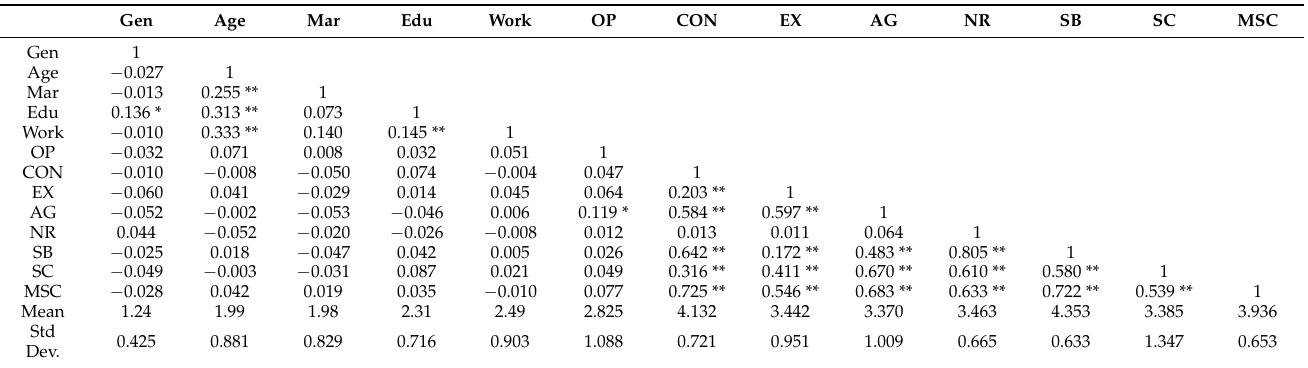
Table 2. Standard Deviations, Means, and